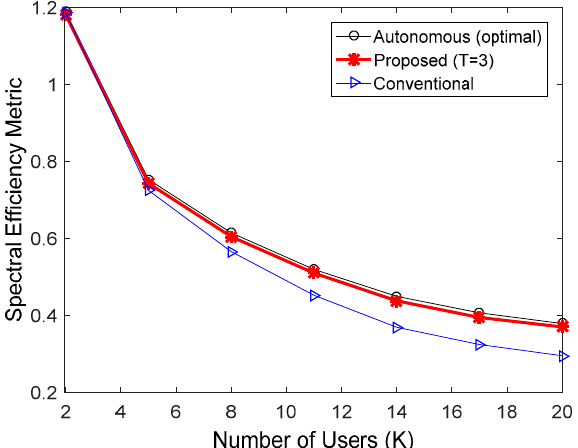
Figure 8. Comparison of spectral efficiency in the IEEE 802.16e downlink when the MCS level was fixed at 8.